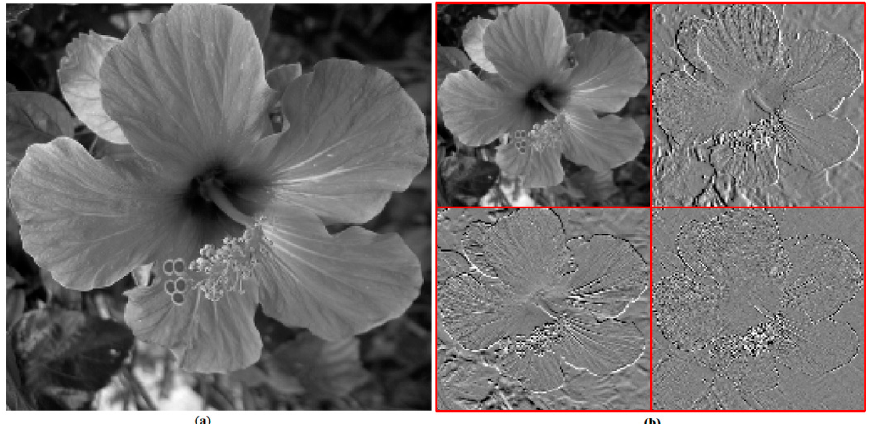
Figure 2. Wavelet decomposition. ( a ) Original image; ( b ) from left to right and top to bottom: approximation, horizontal, vertical, and diagonal images.